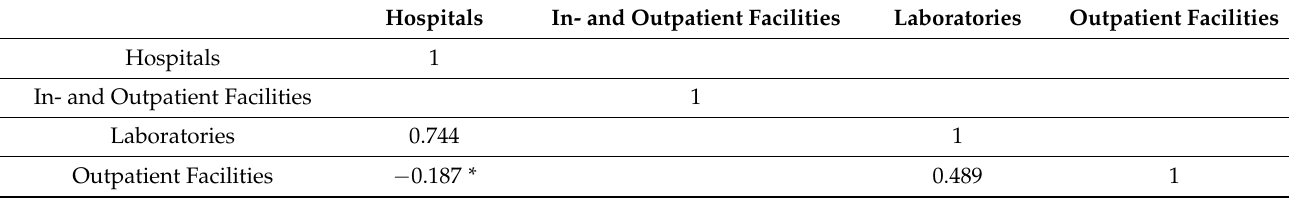
tories and inversely and weakly correlated to outpatient facilities. Clinical laboratories are medium and direct correlated to clinical laboratories (Table 2). medium and direct correlated to clinical laboratories (Table 2). Table 2. Correlation matrix, Africa. Table 2. Correlation matrix, Africa.